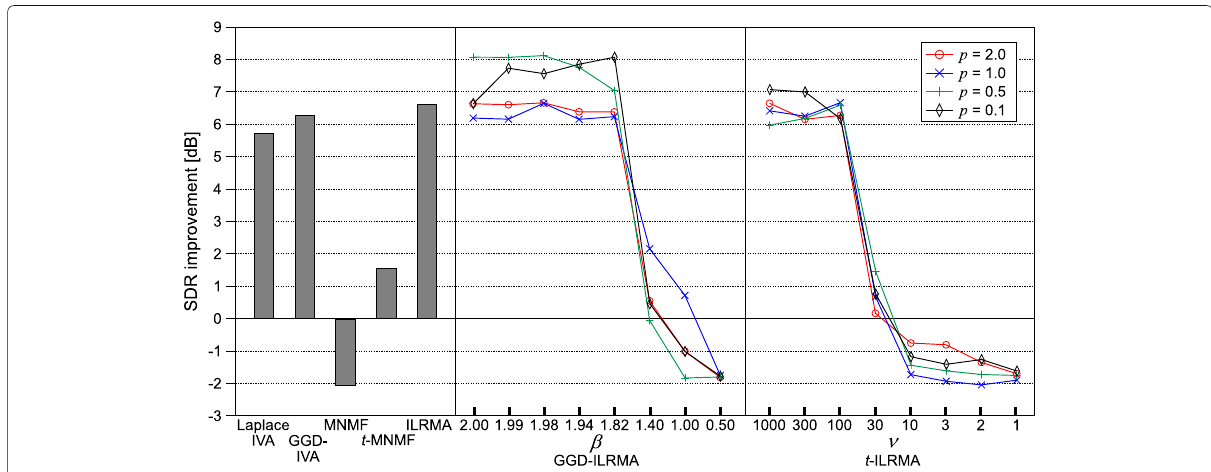
Fig. 13 Average SDR improvements of Speech 1 with E2A_2 signal using fixed parameters. The results for GGD-IVA and t -MNMF using β = 1.0 and ν = 1 are shown, which are their best parameter settings